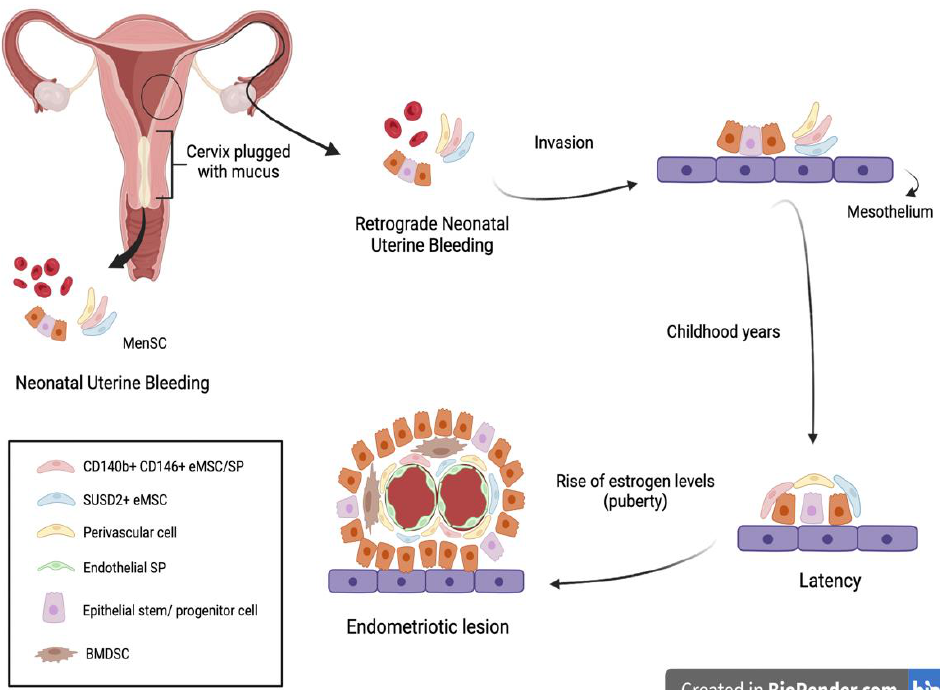
Figure 2. In some neonates, the withdrawal of maternal progesterone causes a shedding of the en- dometrium causing neonatal uterine bleeding. Similar to menstruation, this blood contains epithelial stem cells and MenSC. The passage of these fragments through the vagina can be obstructed by the presence of a cervix plugged with mucus. Therefore, it is hypothesized that the fragments follow a retrograde route through the fallopian tubes and invade the mesothelium. There, they remain latent during childhood until the rise of estrogen levels during puberty, at which point they are activated and form an endometriotic lesion [6]. BMDSC—bone marrow-derived stem cells; SP— side